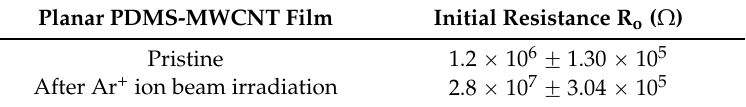
Table 1. Initial resistance (R o ) of planar PDMS-MWCNT film before and after Ar + ion beam